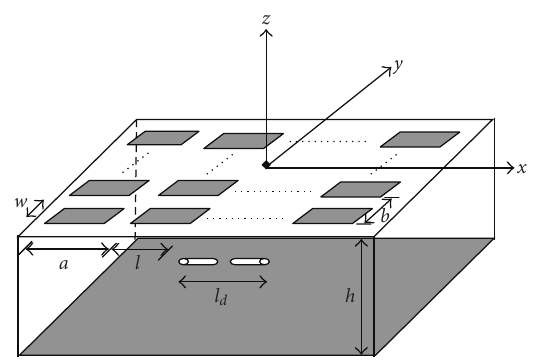
Figure 1: The geometry of the practical printed-circuit leaky-wave periodic patch antenna.